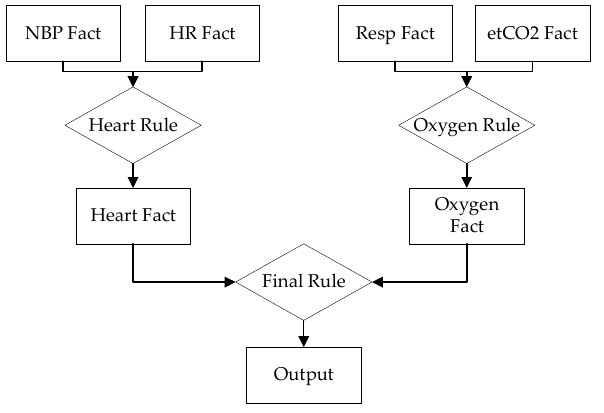
Figure 3. First GDES